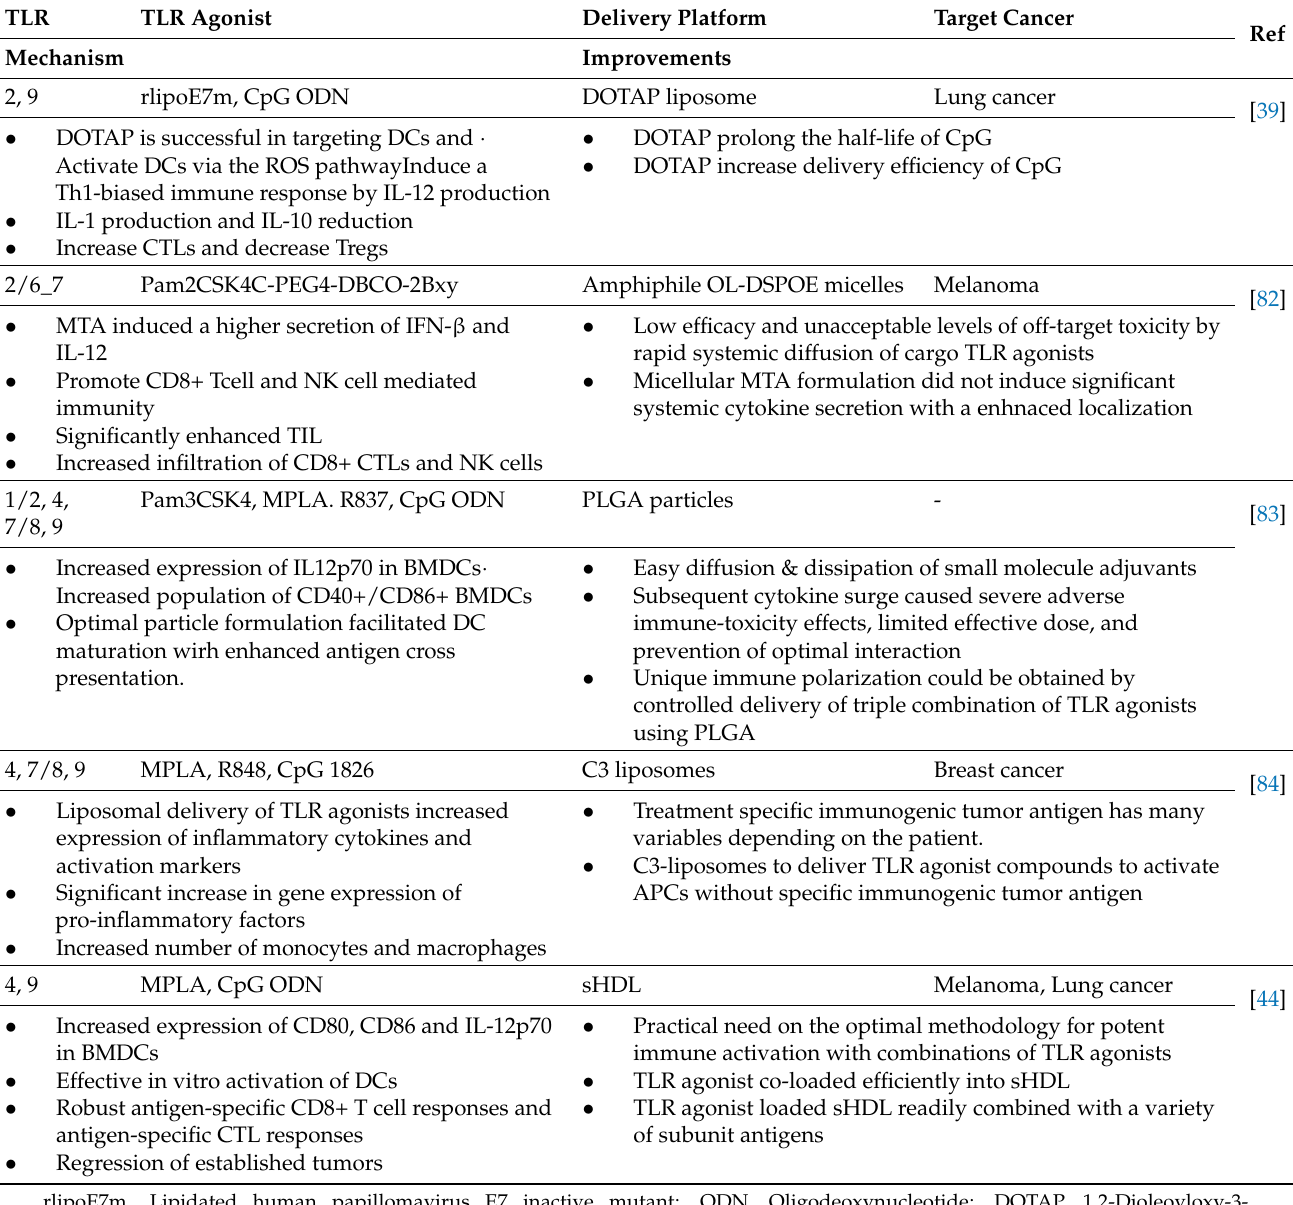
Table 3. Strategies in multiple TLR agonist